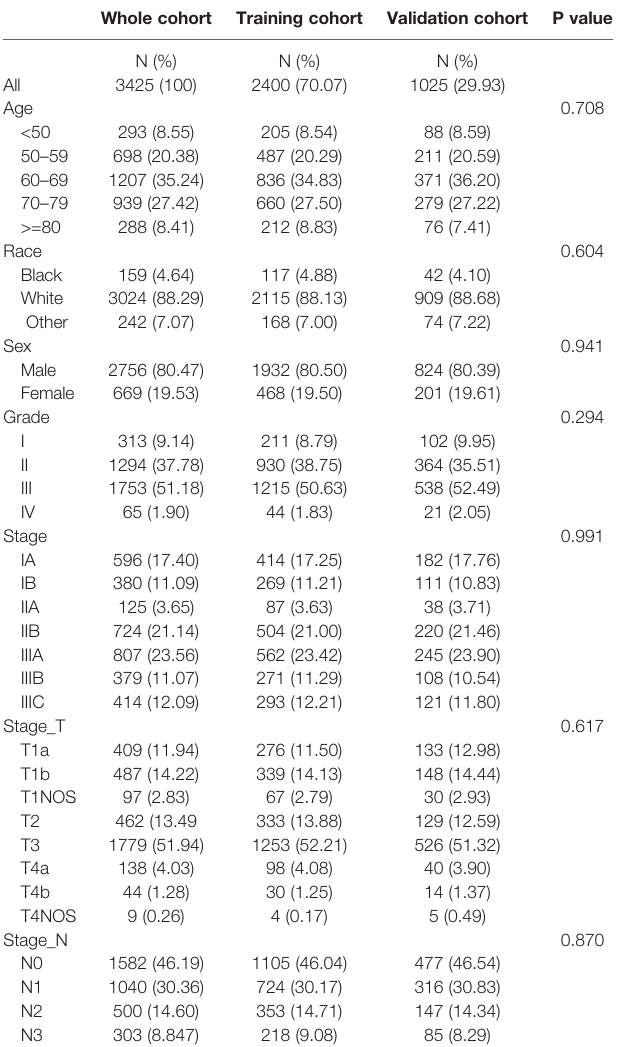
TABLE 1 | Demographic and clinicopathological characteristics of patients with gastroesophageal junction carcinoma. Whole cohort Training cohort Validation cohort P